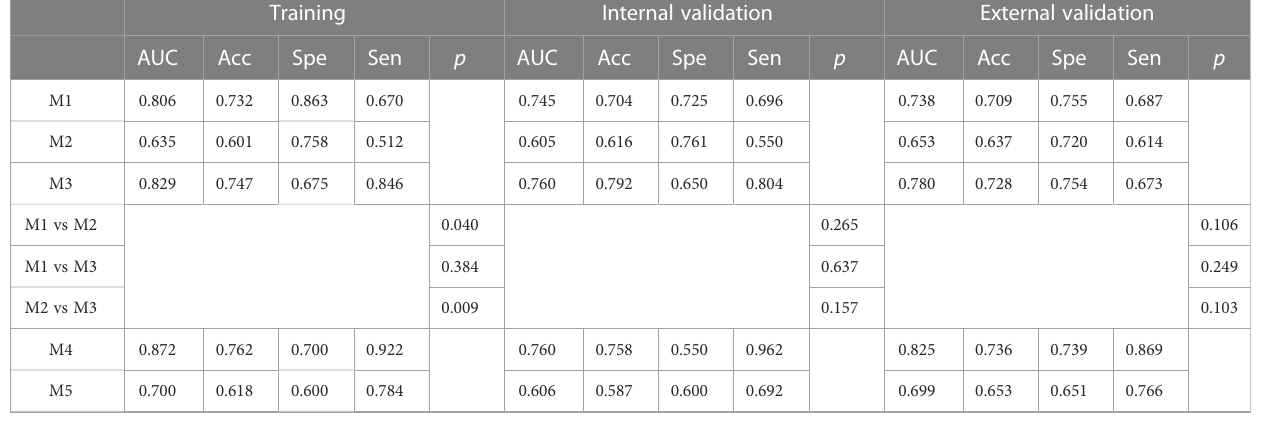
TABLE 3 Comparisons of the combined radiomics signatures, clinical models and nomogram